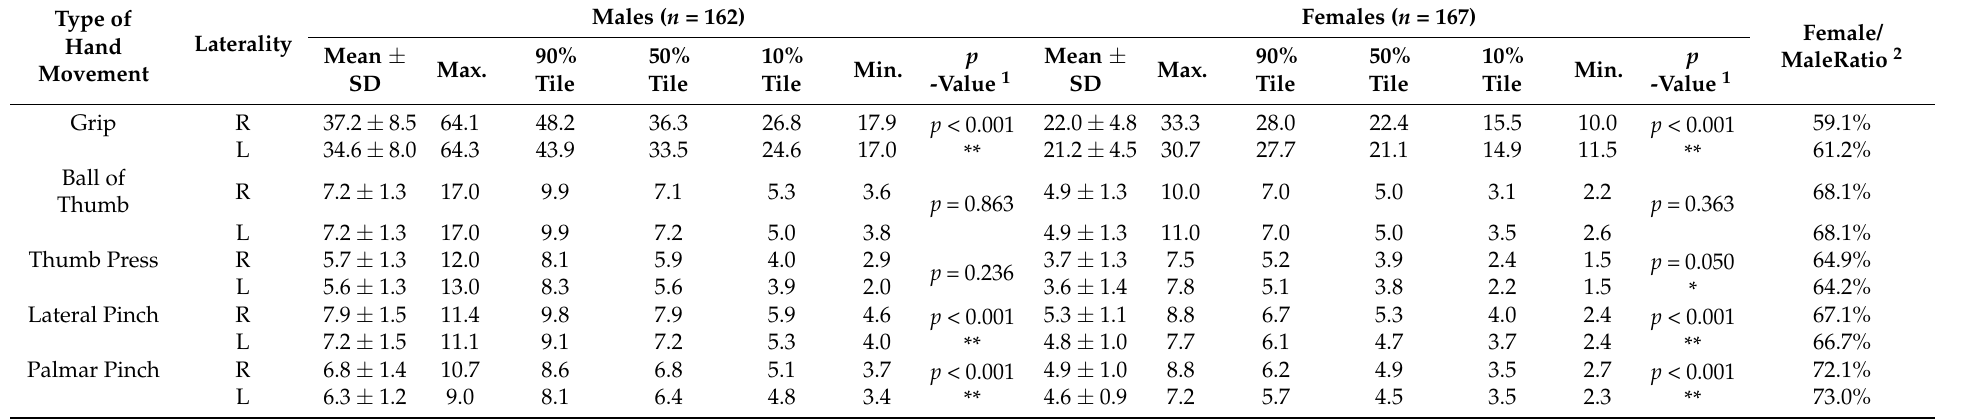
Table 2. Statistics summary of strength by type of hand movement, sex, and hand laterality (Unit: kgw). Type of Hand